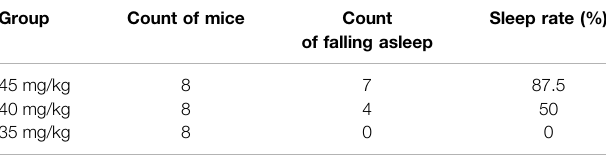
TABLE 3 | Effect of Hp-associated chronic gastritis on the experiment of subthreshold dose of sodium pentobarbital-induced sleep. Group Count of mice Count of falling